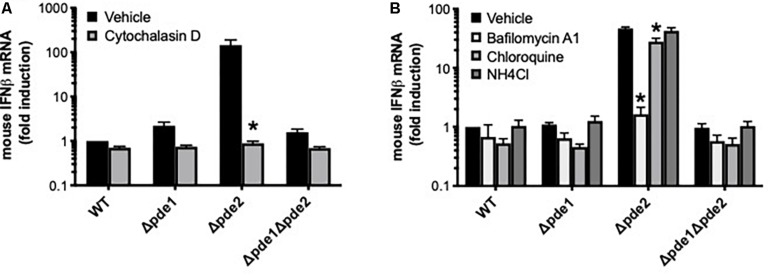
The induction of IFNβ by phosphodiesterase 2 mutant pneumococci requires phagocytosis. (A) Relative induction of IFNβ mRNA was measured in mouse macrophage-like RAW264.7 cell cultures infected 2 h with the indicated bacteria in the presence or absence of cytochalasin D as a means of inhibiting actin polymerization (N = 3 experiments). (B) Relative induction of IFNβ mRNA was measured in mouse macrophage-like RAW264.7 cell cultures infected 2 h with the indicated bacteria in the presence or absence of the indicated inhibitors pf phagosomal processing (N = 3 experiments). For both panels, mouse IFNβ mRNA was measured and normalized to 18S rRNA using qPCR, and expressed relative to the cells infected by WT bacteria. For both panels, asterisk (*) indicates P < 0.05 compared to vehicle.